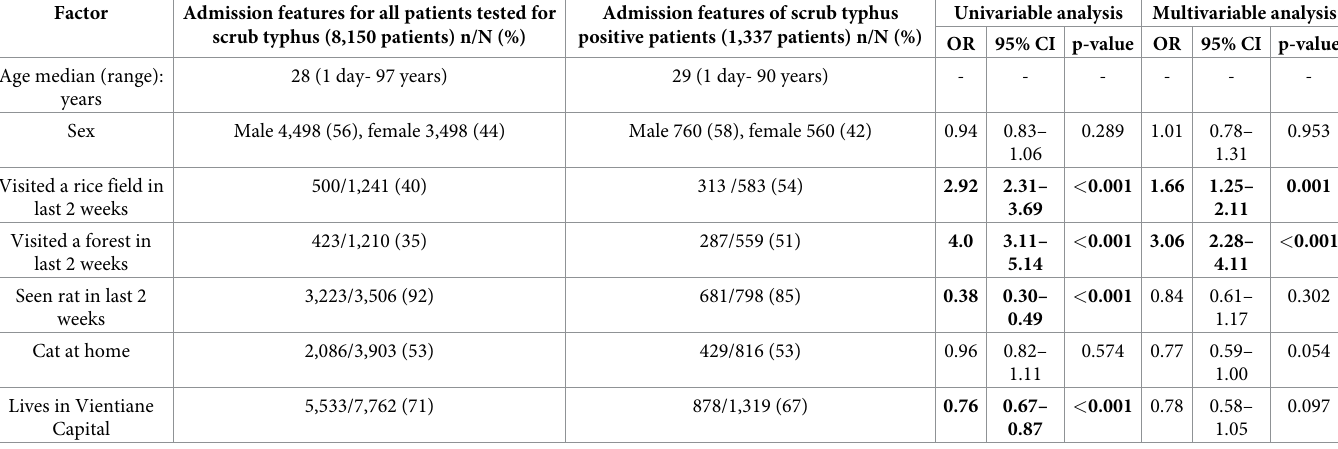
Table 1. Univariable and multivariable logistic regression for factors associated with scrub typhus positive patients from all patients tested for scrub typhus by RDT. n = number of patients with feature, N = number of patients with result (%). The data from all individual patients were included in the study although denominators vary for different parameters due to incomplete data. Factor Admission features for all patients tested for scrub typhus (8,150 patients) n/N